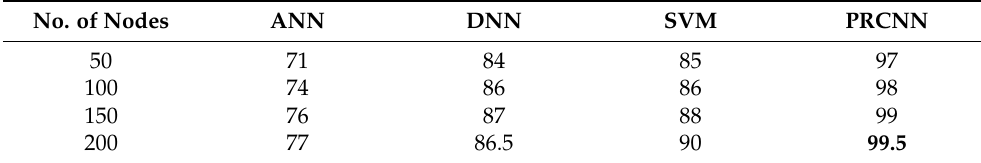
Table 4. Accuracy comparison analysis between proposed and existing classifiers.